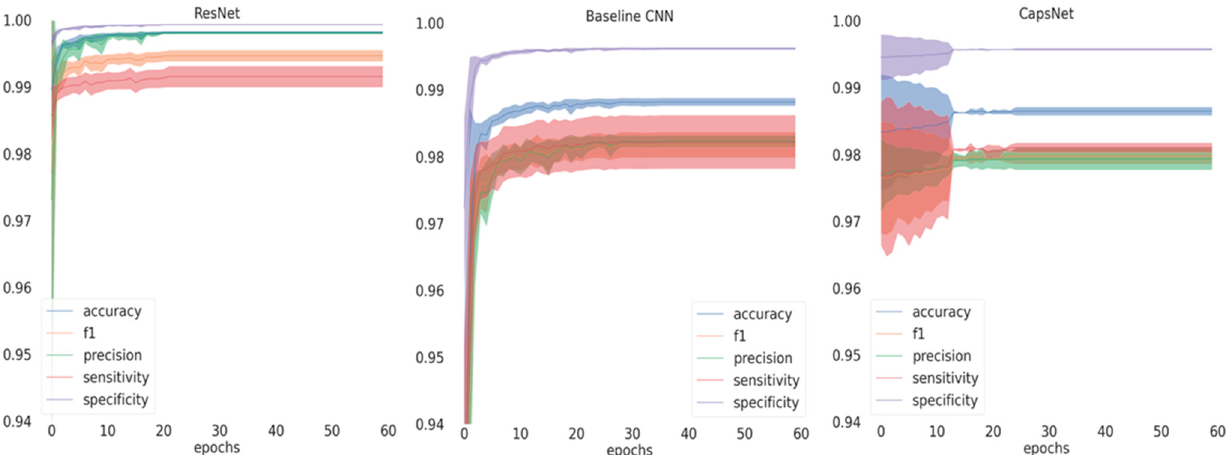
Figure 1. Training history depicting the mean and standard deviation of the metrics on the validation set across splits for the three models. The solid lines represent the mean and the shaded area the standard deviation. CNN: Convolutional Neural Network.